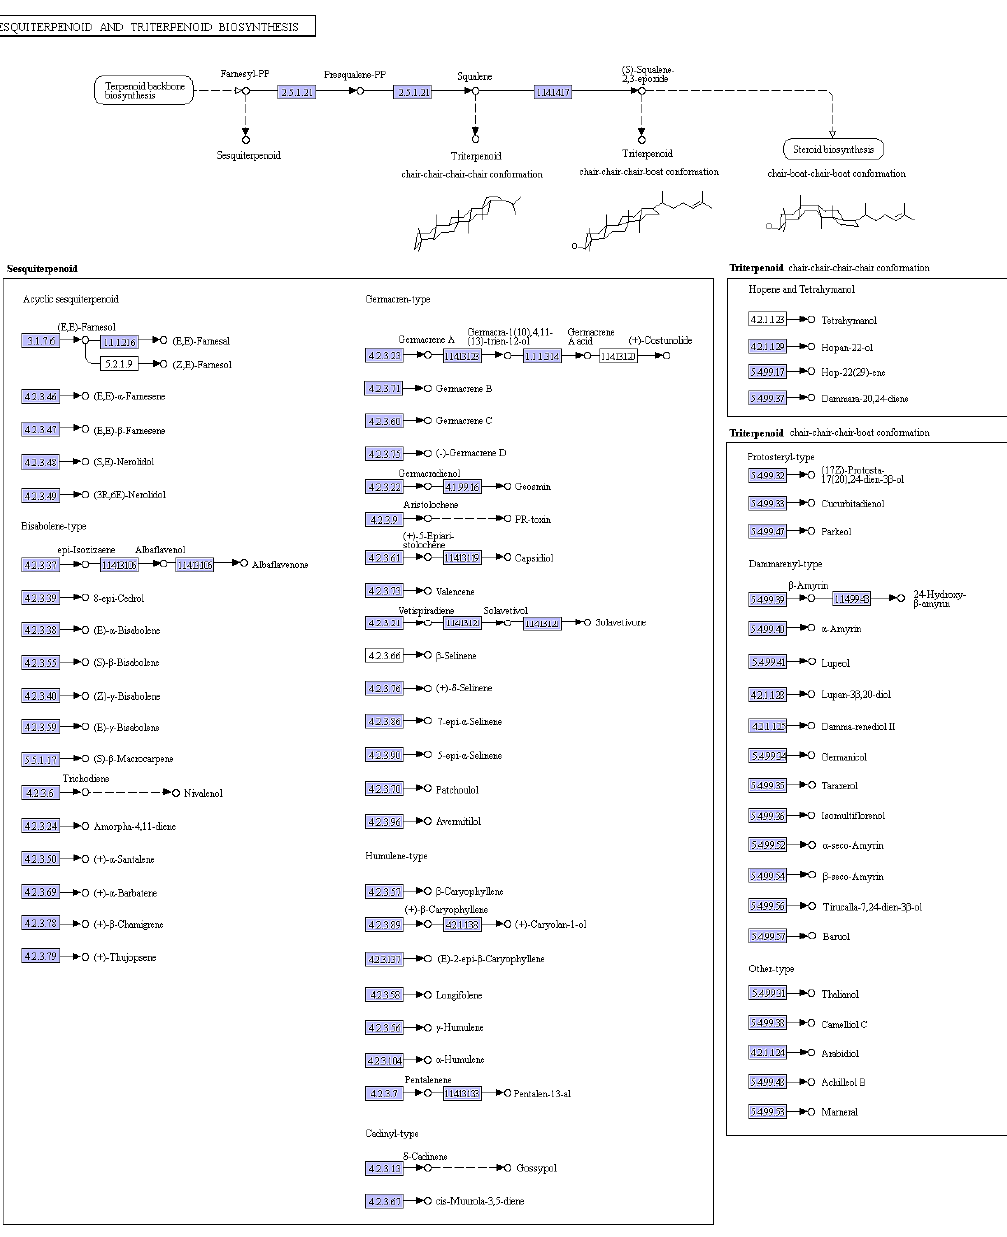
Figure 3. Sesquiterpene and terpenoid backbone biosynthesis pathway in M. roridum .